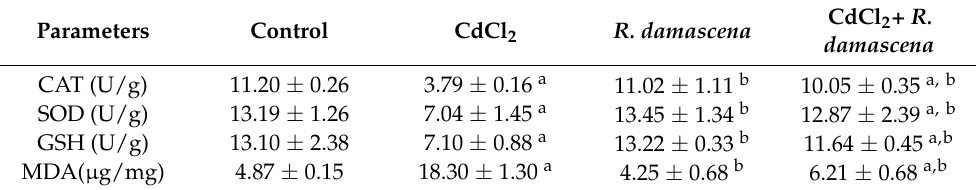
Table 6. Effects of R. damascena methanolic extract (100 mg Kg − 1 ) on oxidative stress enzymes and